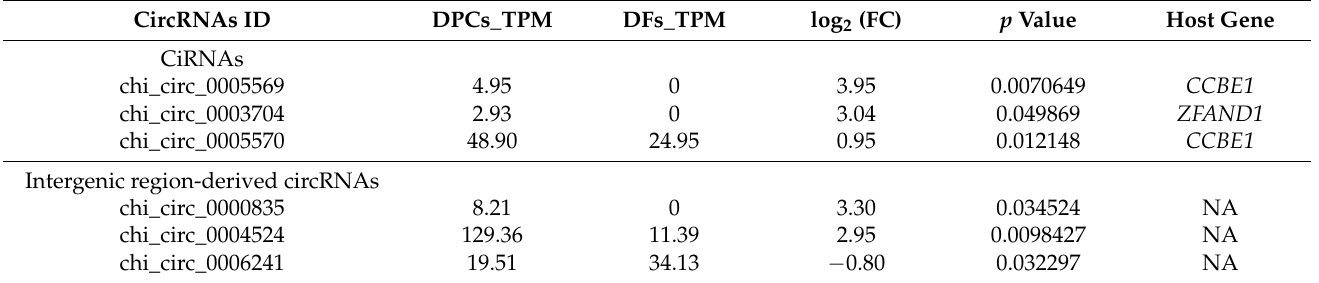
Table 2. Differentially expressed ciRNAs and intergenic region-generated circRNAs between goat DPCs and